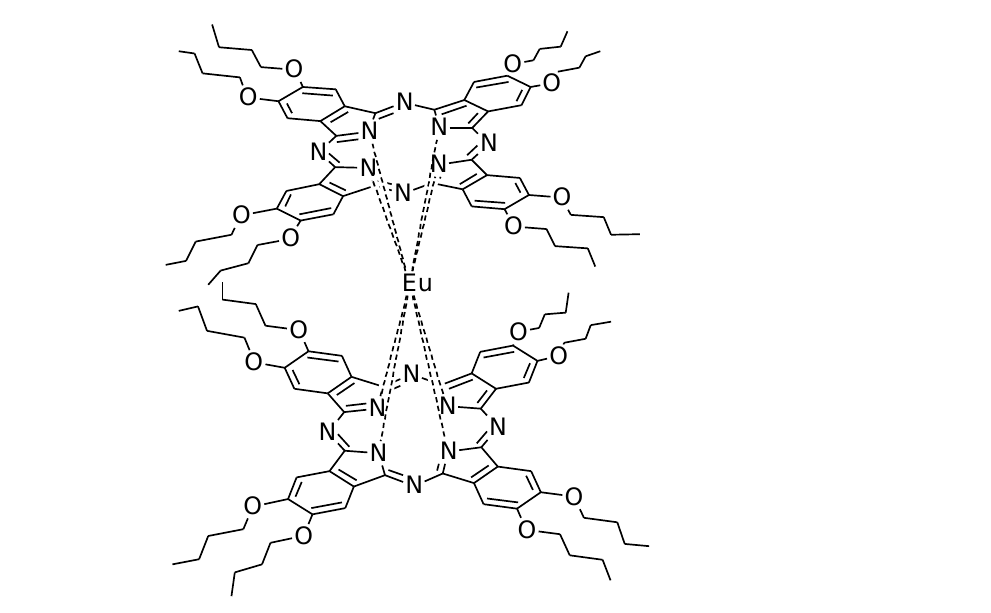
Figure 2. The chemical structure of the double-decker europium(II) phthalocyanine peripherally substituted with eight buthoxy groups [35].